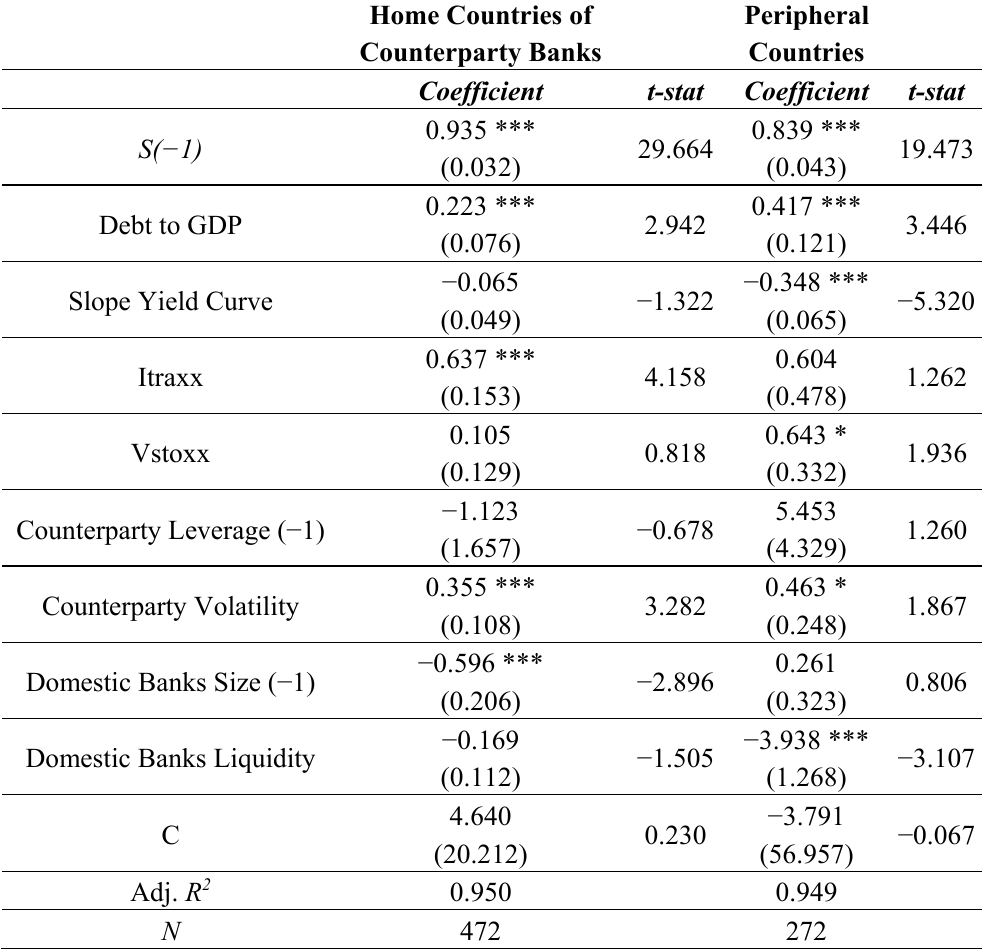
Table 6. Pooled Regression Results of Subgroups (long